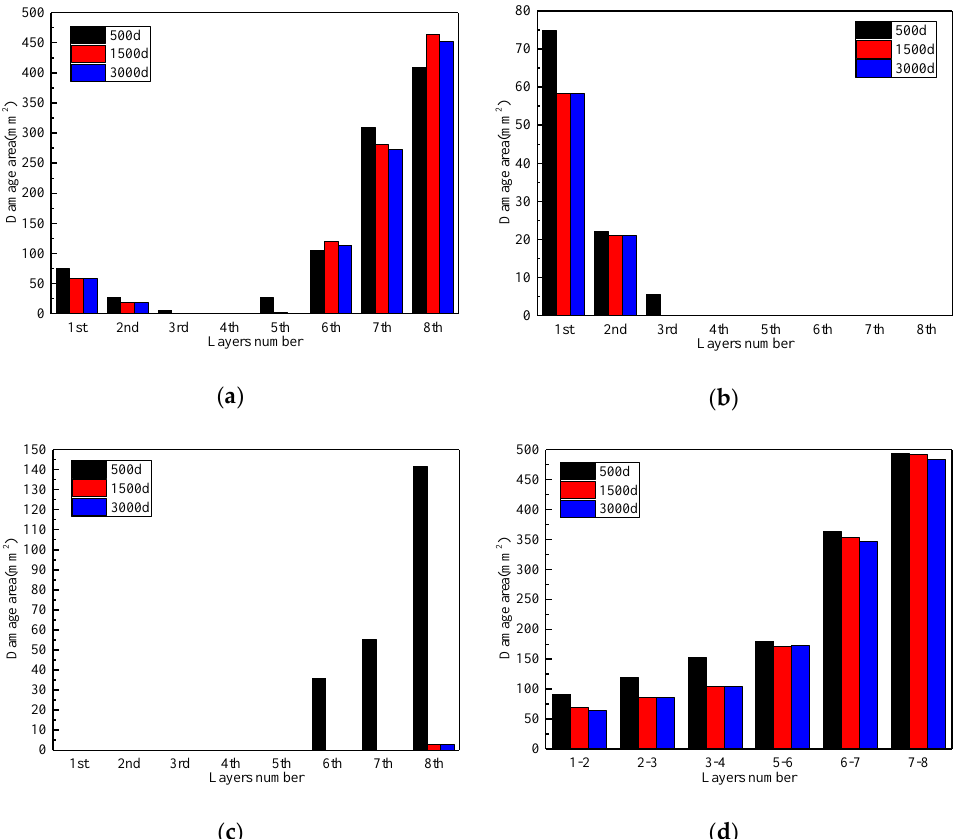
Figure 15. Distribution of different damage modes with different stitching thread thicknesses after the low-velocity impact damage: ( a ) MTF; ( b ) FCF; ( c ) FTF; and, ( d ) DF.